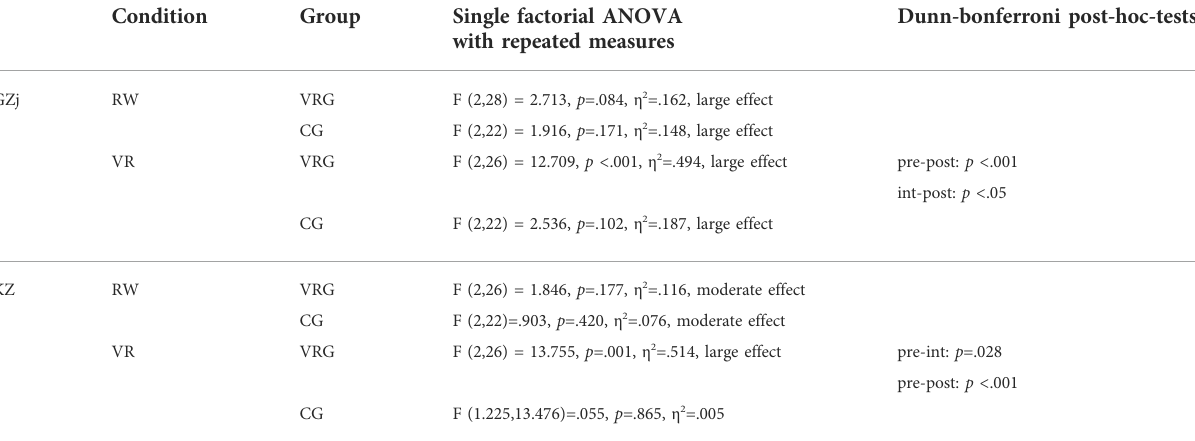
TABLE 2 Results of single factorial ANOVA with repeated measures for “ response time ” (s) for each attack (GZj, KZ), for each condition (RW, VR), each group (VRG, CG) and Dunn Bonferroni